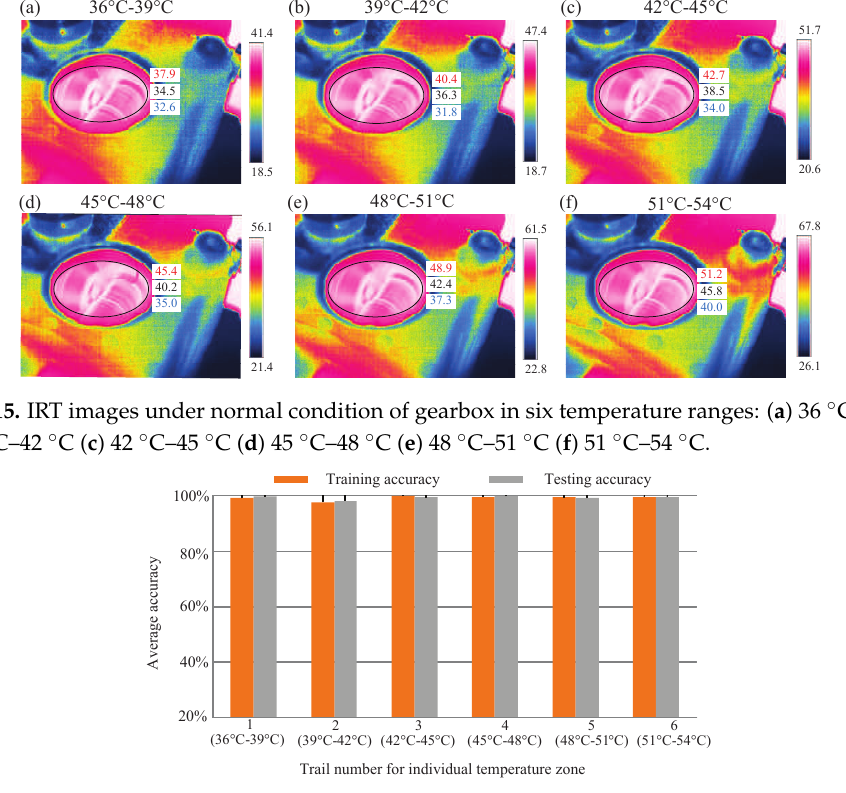
Figure 16. Diagnosis results for each temperature range using proposed IRT–CNN